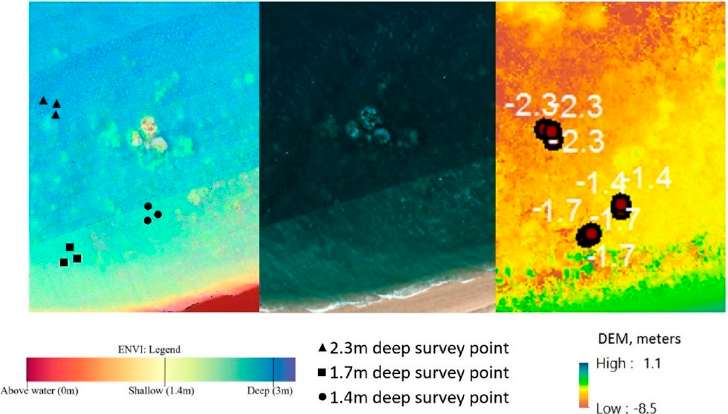
Figure 6. Depth approximation non-homogeneous composition ( left —ENVI depth approximation; centre —Figure 5 extract; right —Agisoft Photoscan DEM (Digital Elevation Module) depth approximation).